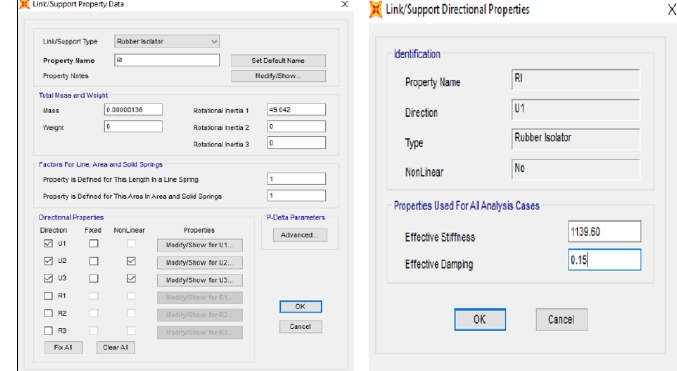
Figure 5: Link support properties.